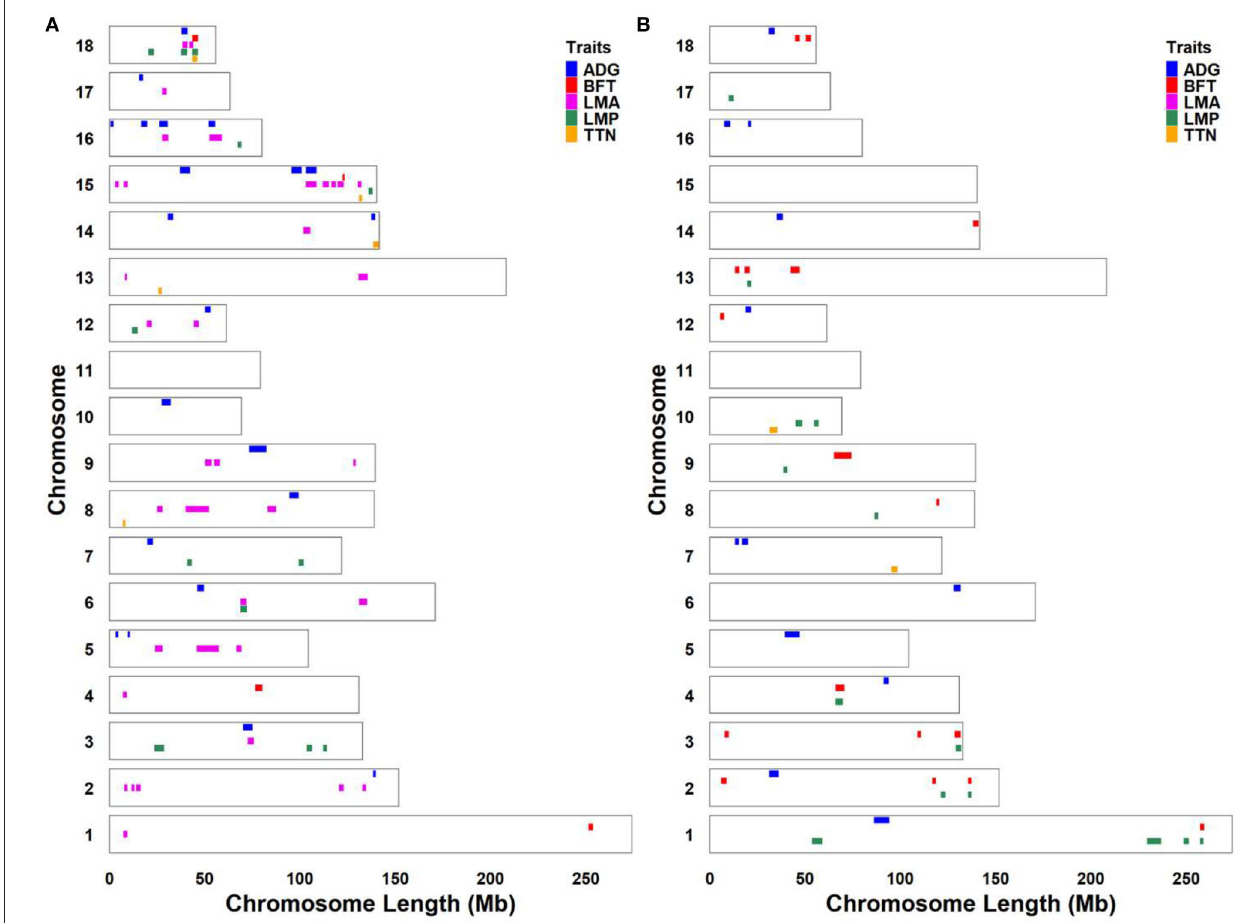
FIGURE 2 | Genomic distribution of significantly unfavorable ROH regions for economic traits. (A) S21 population. (B) S22 population. S21, Duroc pigs of American origin; S22, Duroc pigs of Canadian origin; ADG, average daily gain at 100kg; BFT, backfat thickness; LMA, loin muscle area; LMP, lean meat percentage at 100kg; and TTN, total teat